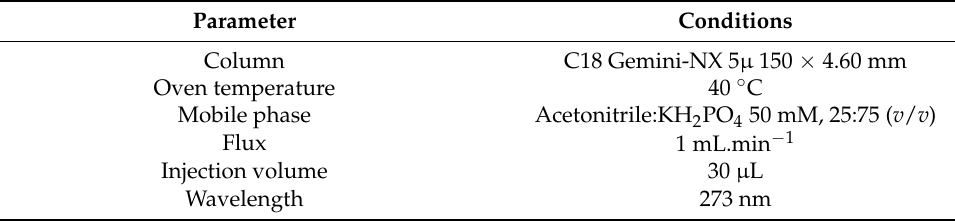
Table 5. Chromatographic conditions for articaine